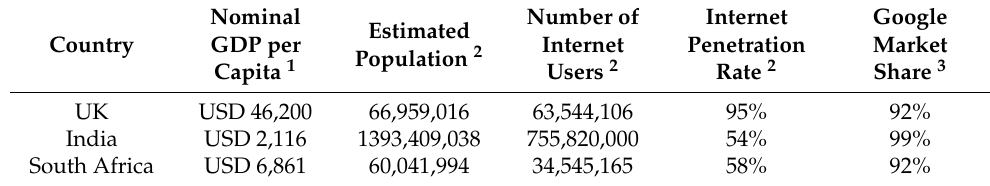
Table 1. 2021 Demographic and socioeconomic data of the three countries of interest.